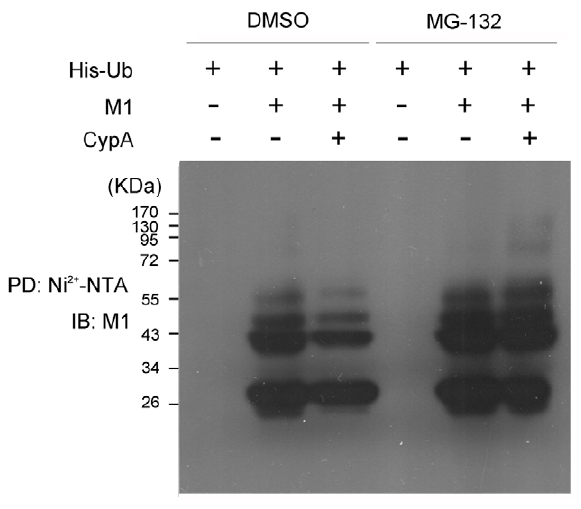
Figure 7. In vivo ubiquitination assay suggested that CypA increased the ubiquitination of the M1 protein. 293T/CypA 2 cells were transfected with expression constructs for Myc-tagged CypA, FLAG-tagged full-length M1, and His-tagged ubiquitin. Forty hours post-transfection, the proteasome inhibitor MG-132 (dissolved in DMSO) was added to the cells for 4 h at a final concentration of 10 m M. Cell extracts were then immunoprecipitated with Ni2 + -NTA beads. The eluted proteins were analyzed by western blotting using an anti-FLAG monoclonal antibody.